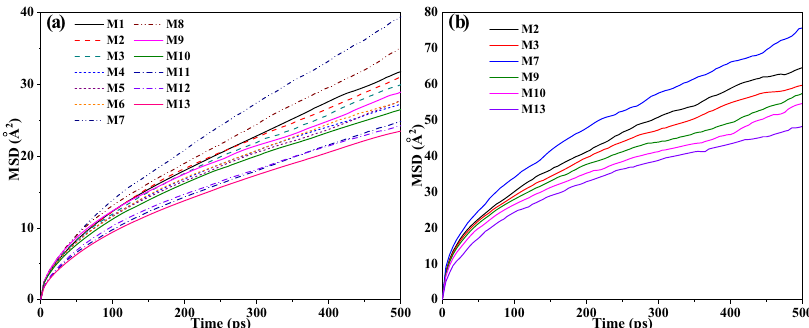
Fig. 6 MSDs of the unaged and aged PDMS models as a function of simulation time. a main chain, and b oxygen of hydroxyl group.